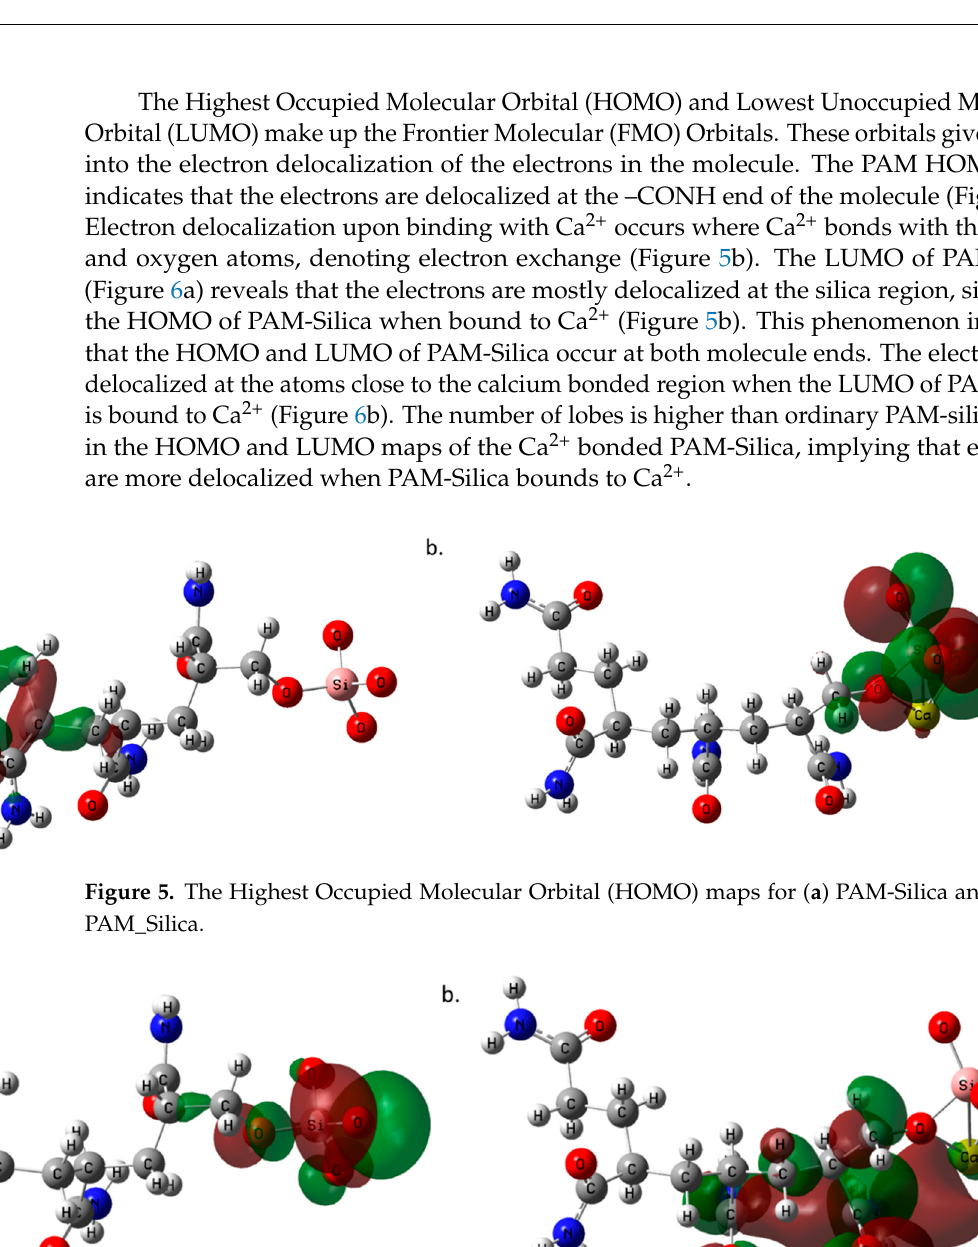
Figure 4. The molecular electrostatic potential maps for ( a ) PAM ‐ Silica and ( b ) Ca ‐ PAM_Silica2.